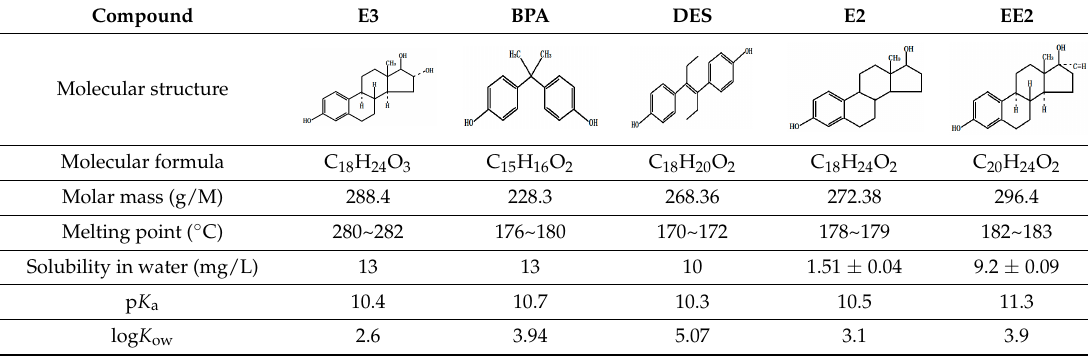
Table 1. General properties of the tested estrogens.